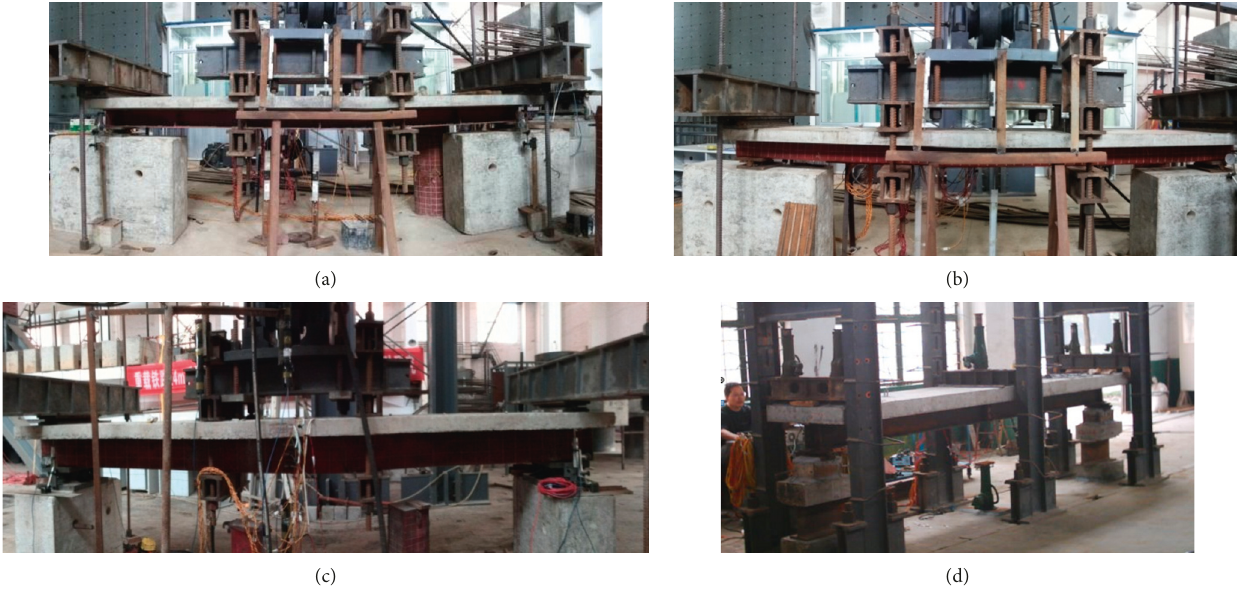
Figure 2: Test setup on the spot: (a) SCB1 ∼ 2, (b) SCB3 ∼ 8, (c) SCB9 ∼ 13, and (d) SCB14 ∼